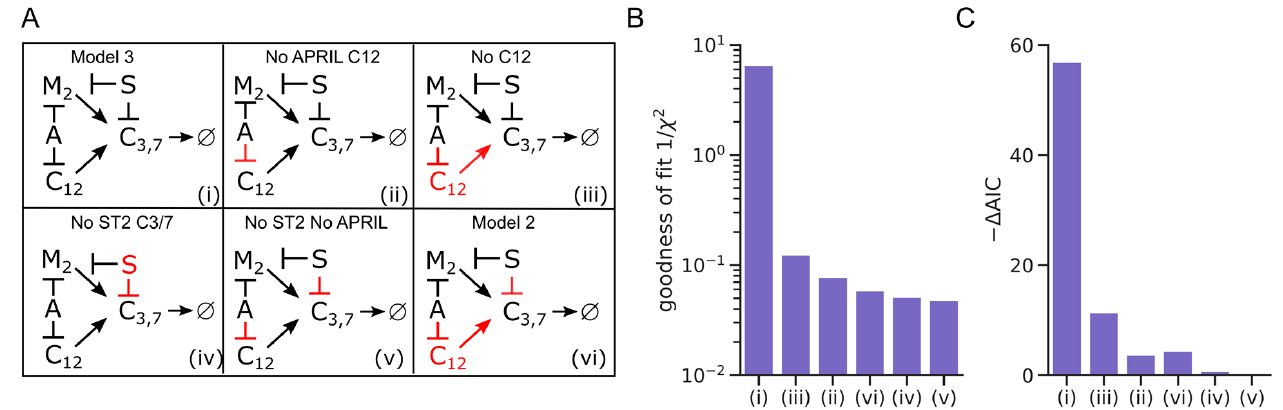
Figure 4. All considered regulatory processes are required to explain the data. ( A ) Different hypothetic network topologies (ii–vi) as submodules of the model shown in (3A), here presented as a condensed version (i). Abbreviations: M2: Model 2; A: APRIL; S: ST2; C12: Caspase 12; C3/7: Caspase 3, Caspase 7. Model components removed from the full model are shown in red. ( B ) goodness-of-fit (1/root-mean-squared error)) for each submodel (ii–vi). ( C ) Akaike information criterion ( − ∆ AIC) for each sub-model compared to the full model (i), where the model with smallest − ∆ AIC is used as a reference and set to